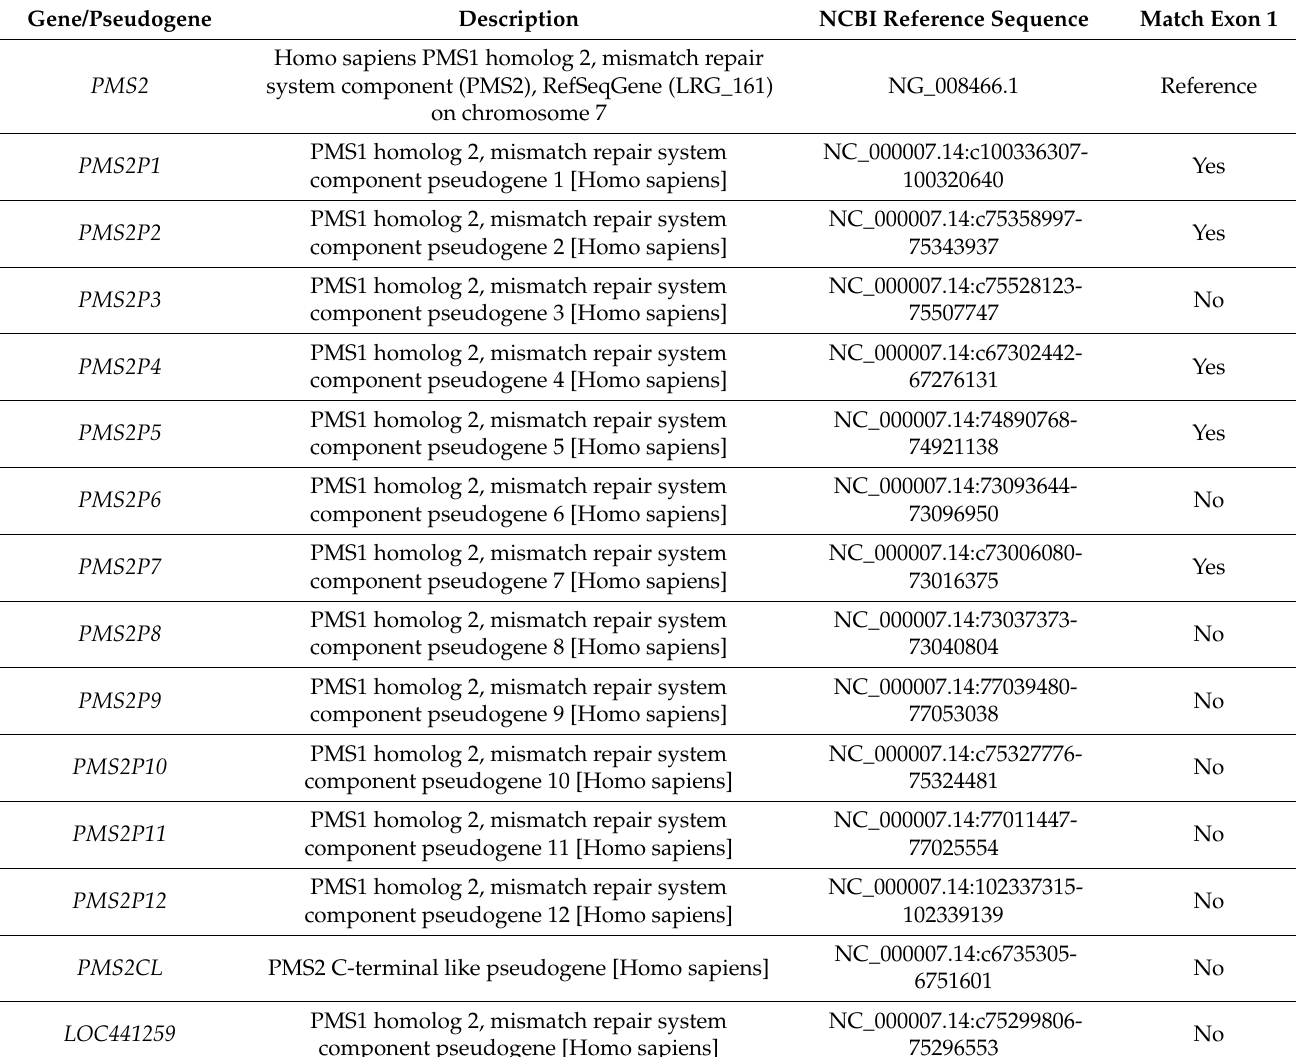
Table 2. PMS2 pseudogenes. NCBI reference numbers and sequences used for alignment and analysis of exon 1 overlap